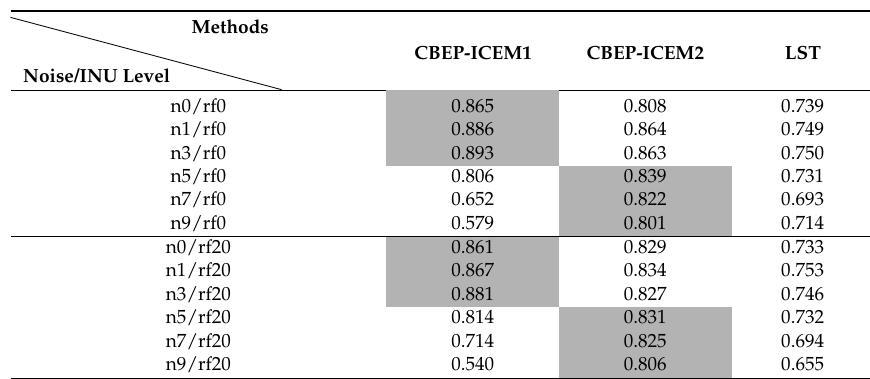
Table 2. Averaged DSI values of lesions detection by CBEP-ICEM1, CBEP-ICEM2 and LST over MR image slices 91–113.